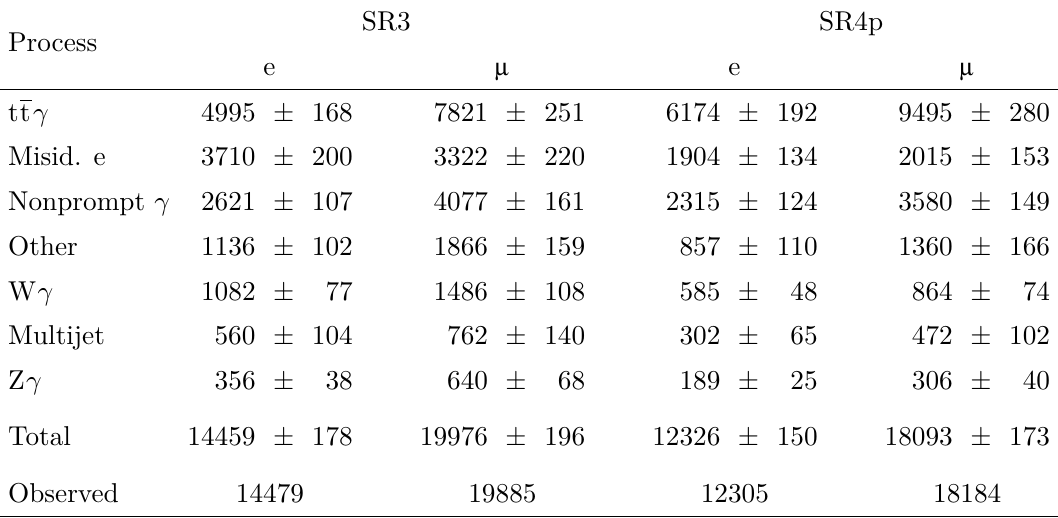
Table 6 . The observed number of events for the SR3 and SR4p signal regions in the e and m channels, and the predicted yields and total post-fit uncertainties in each background